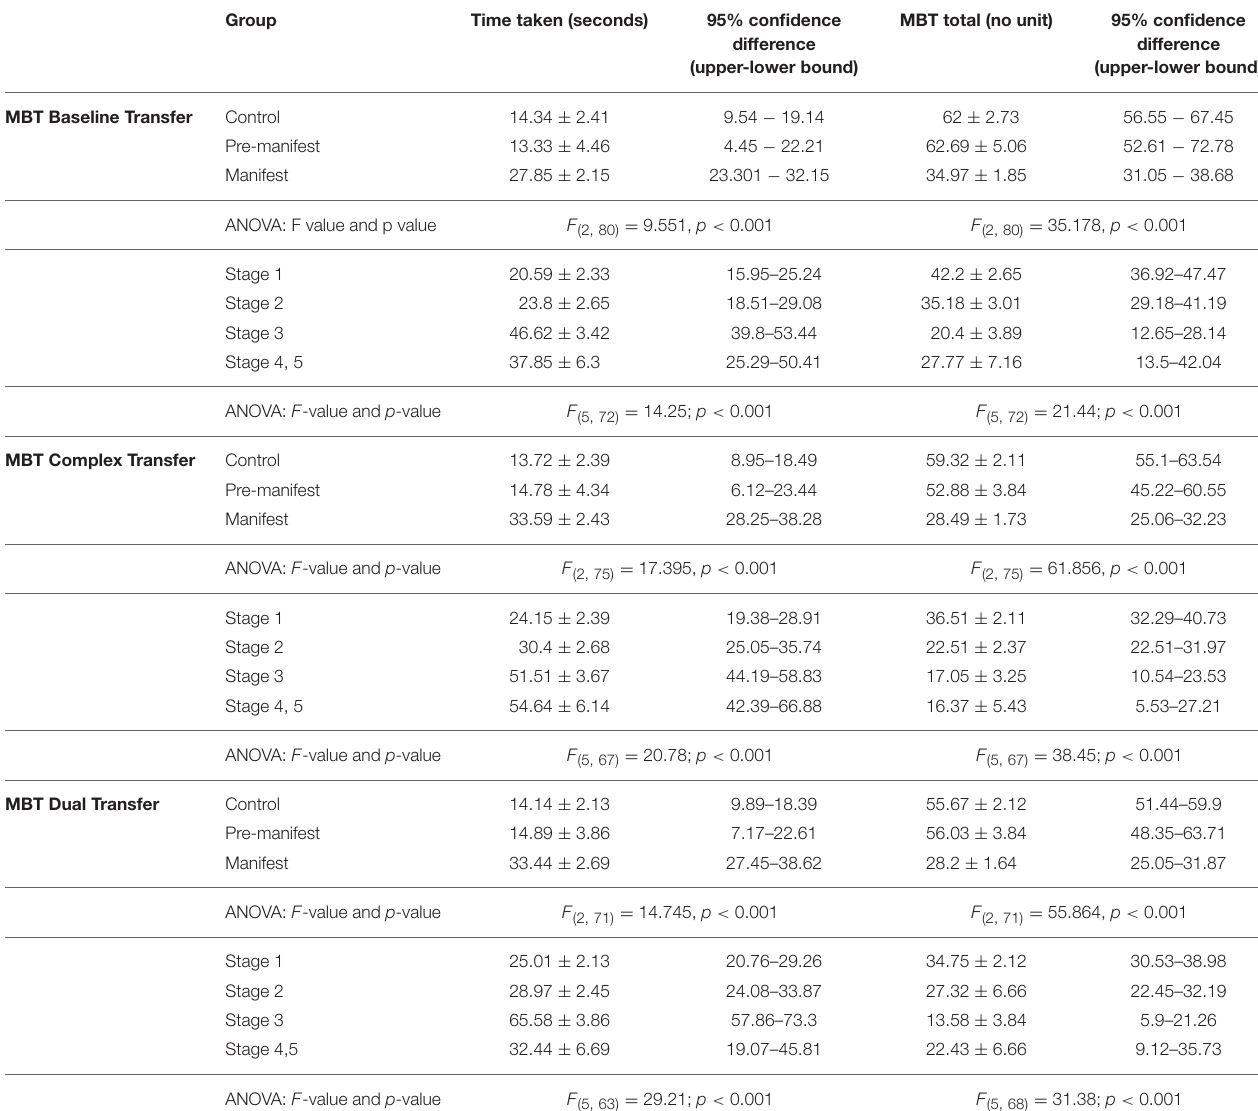
TABLE 3 | Mean, standard deviation and 95% confidence intervals for time taken and mean MBT total scores achieved for each group (Control, Pre-manifest, Manifest; HD disease stage) during each of the MBT transfer items (MBT Baseline Transfer, Complex Transfer, and Dual